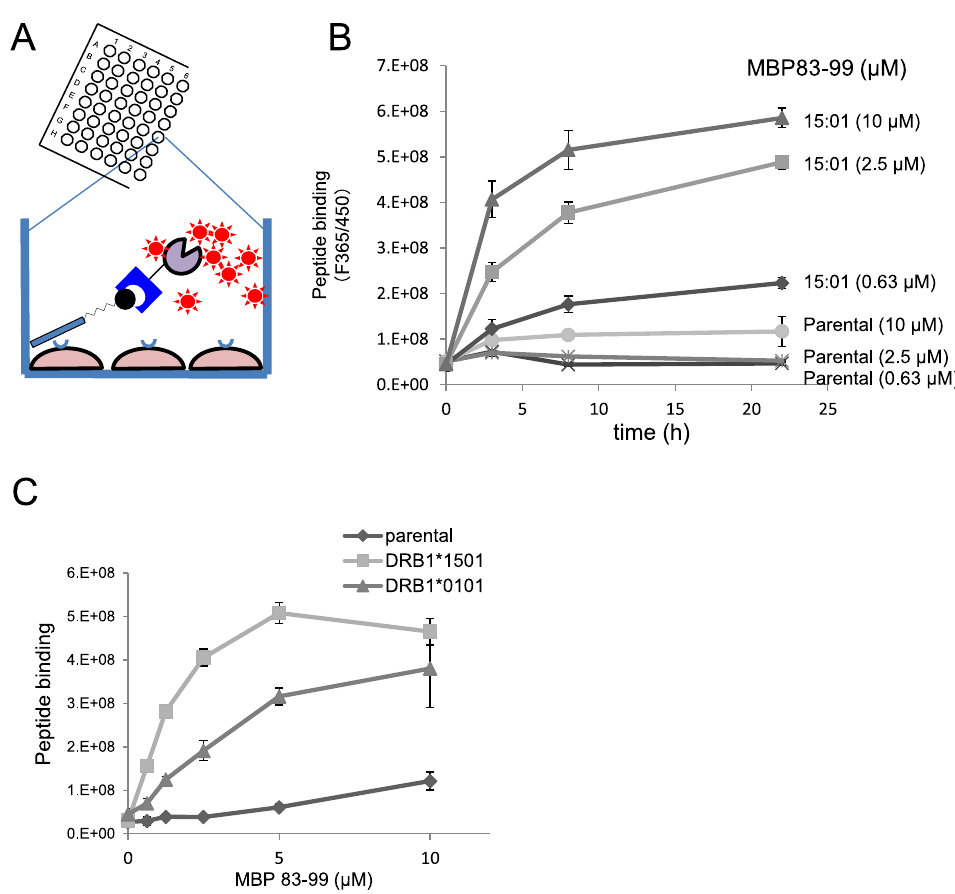
Figure 3. Detection and screening system of antigen peptide binding to HLA on 3T3 cells in 96 well plate. ( A ) Scheme of the detection of HLA-bound peptides on cells in 96 well plates. HLA expressing cells are incubated with biotinylated antigen peptides, and bound peptides are probed with SA- β -gal, followed by enzyme reaction with chromogenic (ONPG) or fluorogenic substrate (4MUG). ( B ) Detection of HLA-bound peptides on 3T3 cells using fluorogenic substrate (4MUG) in 96 well plates. Two 96-well plates of DR15-expressing cells were incubated with MBP83-99 for 6 h, fixed with glutaraldehyde, and subjected to blocking with a blocking solution as detailed in the methods section. Thereafter, biotinylated peptides in one plate were probed with low concentration of SA- β -gal (3,000-fold dilution) and detected by using 4MUG. The other plate was analysed using a chromogenic substrate (ONPG) in Supplementary Fig. 3. ( C ) Time and concentration dependence of MBP83-99 binding to DR15-expressing 3T3 cells. The assay was conducted as in ( B ). In either figure, values shown are mean ± intra-assay deviation expressed as SD from 3 wells in one set of representative